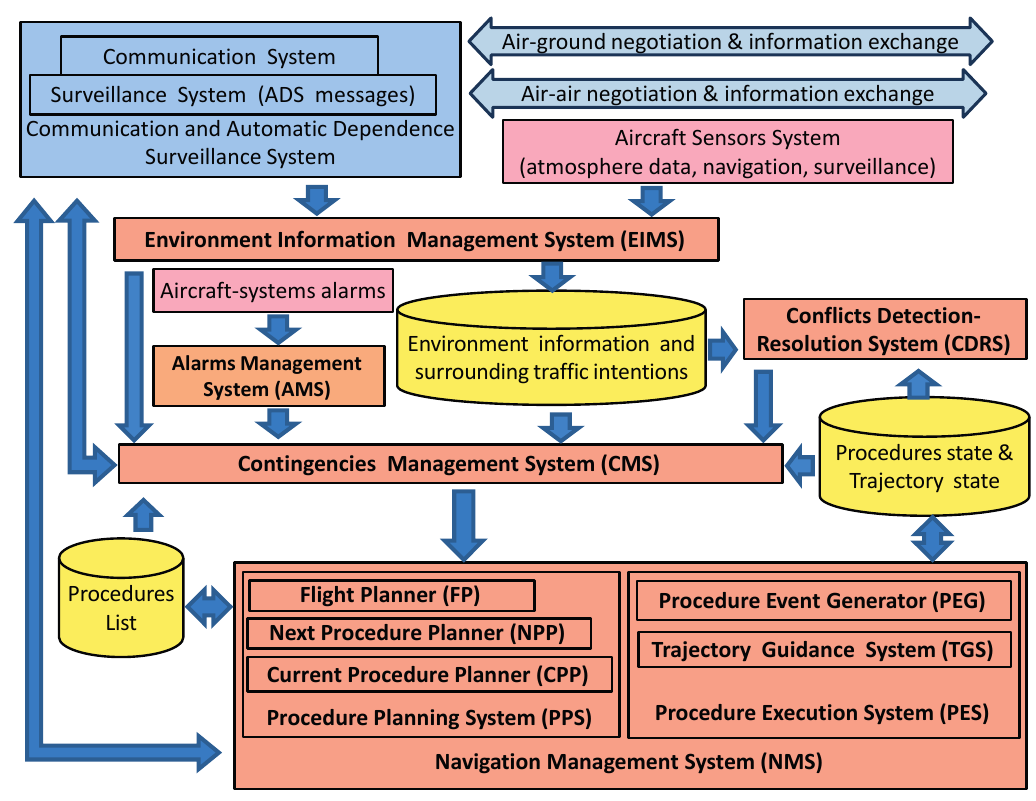
Figure 10. Cockpit HCI